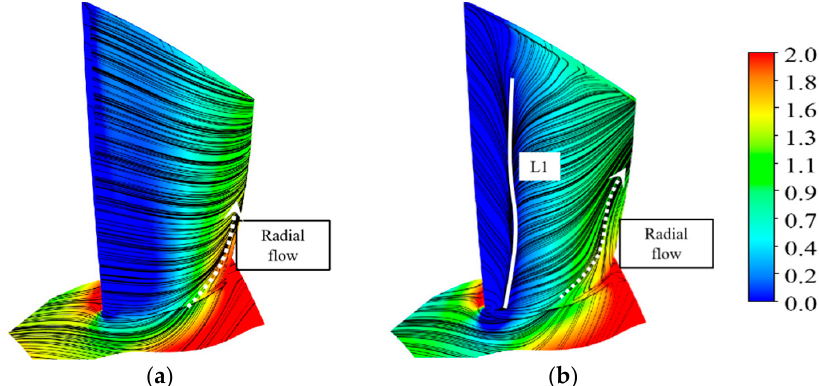
Figure 5. Static pressure contour/limiting streamlines. ( a ) OP1; ( b ) OP2.